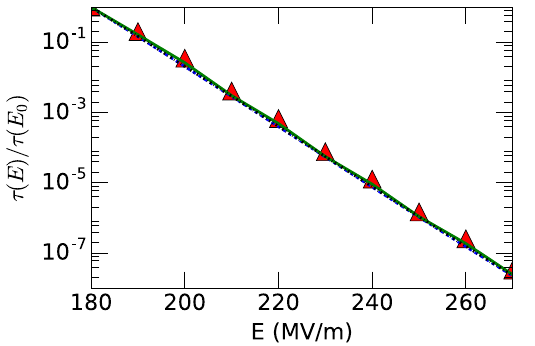
FIG. 5. Mean breakdown time τ as a function of the electric field relative to τ ð E 0 ¼ 180 MV = m Þ , calculated using the exact formula [Eq. (9), solid line], the metastable approximation [Eqs. (12) and (14), dashed line], the metastable approximation with an additional Stirling approximation of π n [Eqs. (14) and (18), dash-dotted line], and the simulation (triangles). The size of the symbols here and in all figures accounts for simulation errors, see Appendix A.